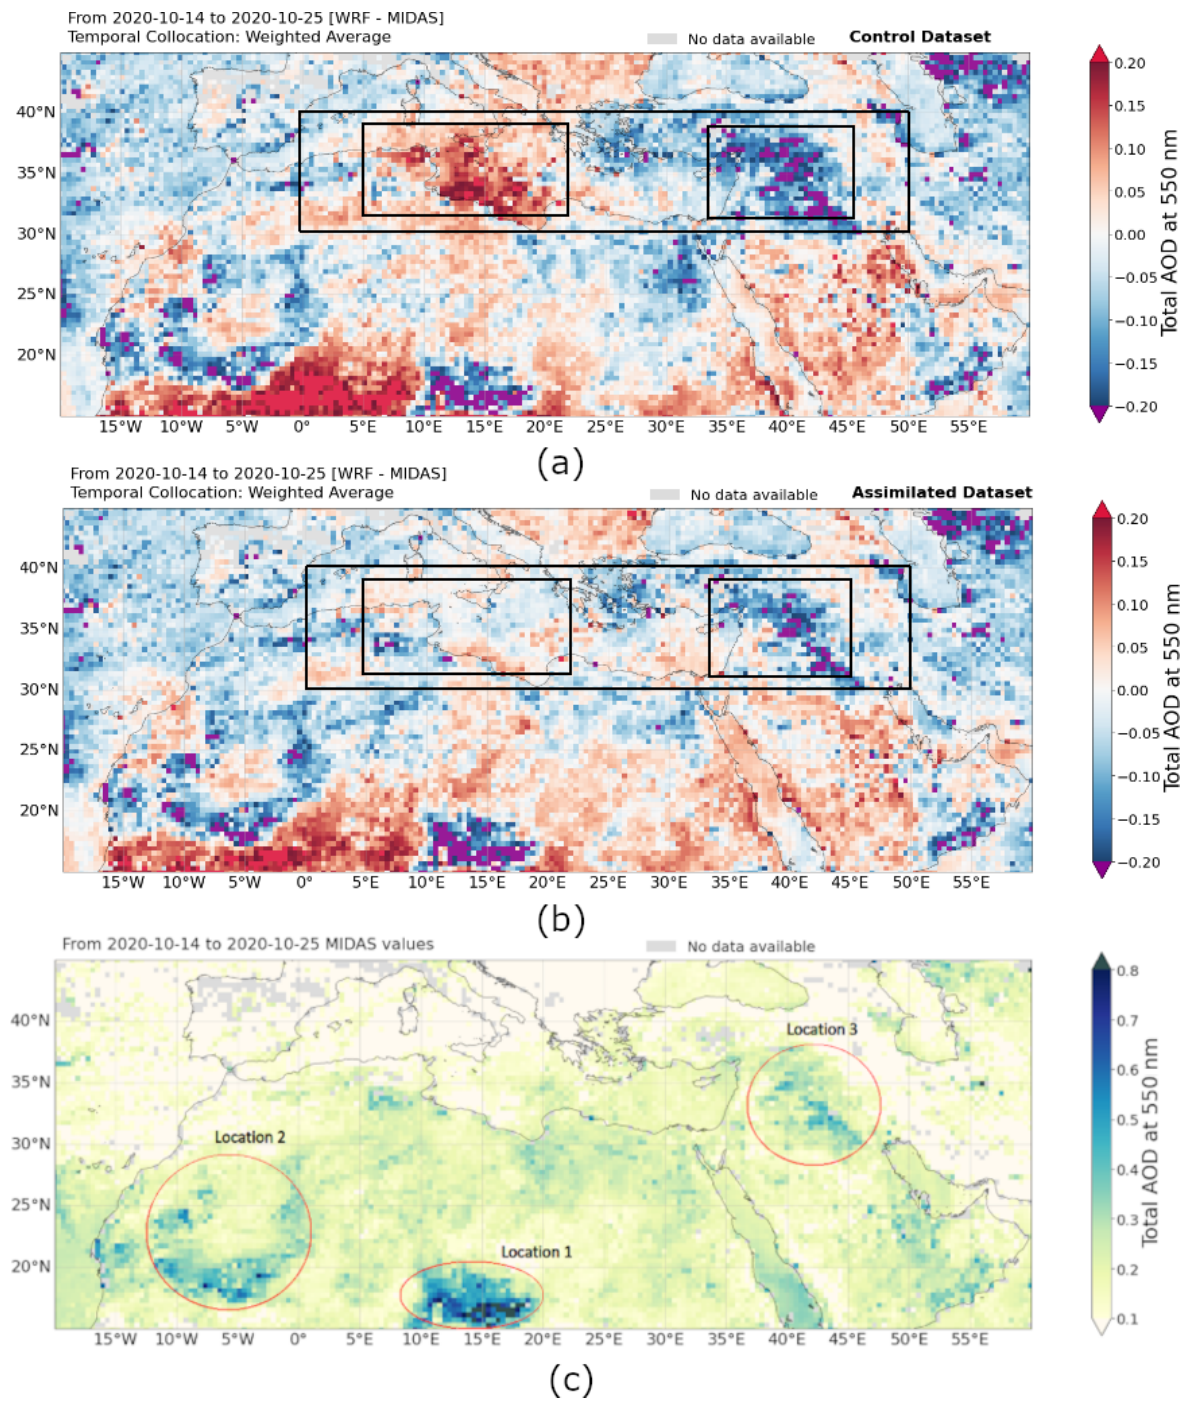
Figure 8. Time-averaged differences in AOD (WRF-MIDAS) for the control run (a) and the assimilated run (b) , where the black rectangles indicate regions of significant improvement when simulating conditions using the assimilated run. Additionally, (c) represents the observed MIDAS AOD values for the time-averaged period of 14–25 October, where the highlighted red circles indicate locations where both runs underestimate